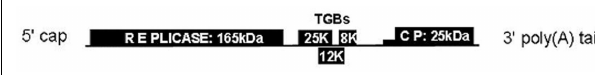
FIGURE 1 | Organization of the PVX genome (not to scale). TGB, triple gene block; CP, coat protein.